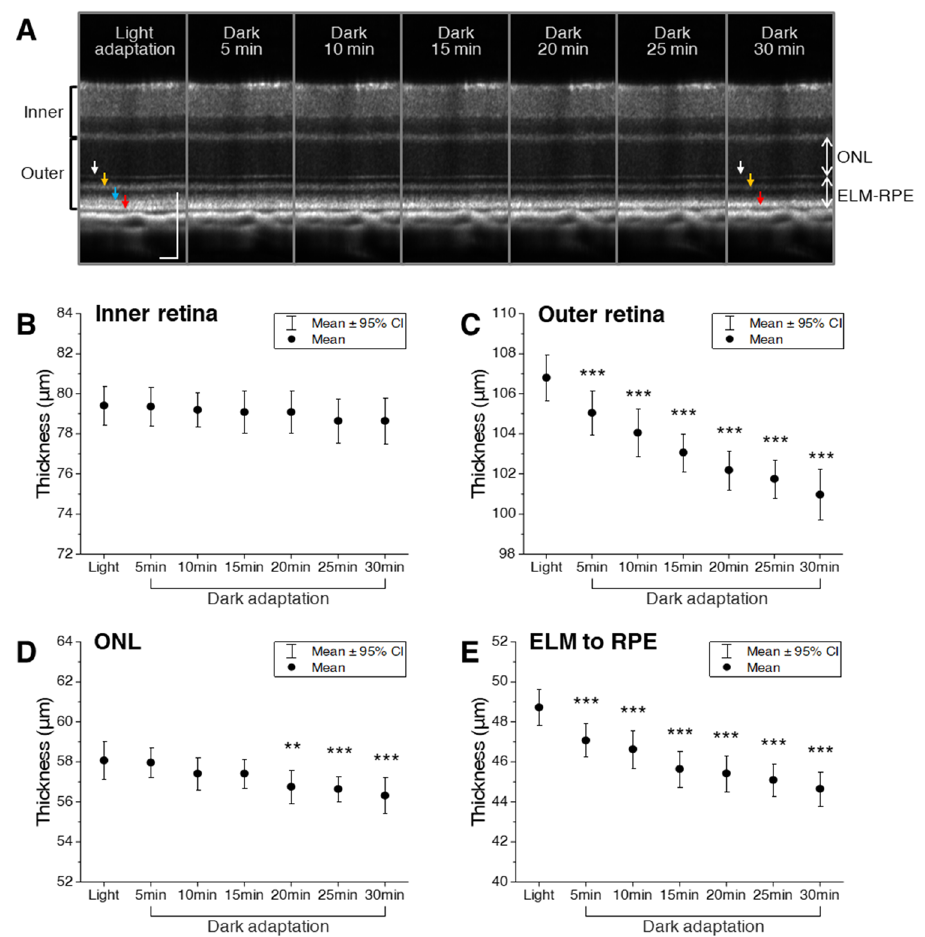
Figure 2. Quantitative measurement of retinal thickness changes during dark adaptation. ( A ) A sequence of OCT images was obtained every 5 min up to 30 min during dark adaptation. Arrows to indicate outer retinal bands: 1st ELM band (white), 2nd ISe and IS/OS band (yellow), 3rd IZ and OS tip band (blue), 4th RPE band (red). ONL outer nuclear layer, ELM external limiting membrane, RPE retinal pigment epithelium, ISe inner segment ellipsoid, IS inner segment, OS outer segment. Thickness measurement of ( B ) the inner retina, ( C ) outer retina, ( D ) ONL, and ( E ) ELM-RPE complex during dark adaptation. Data are represented as mean with 95% confidence intervals (error bars). Significant differences between time points were tested using a one-way repeated measures ANOVA with Bonferroni’s post-hoc tests. N = 14. * p < 0.05, ** p < 0.01, *** p < 0.001 compared to the light-adapted retina. Scale bars: 100